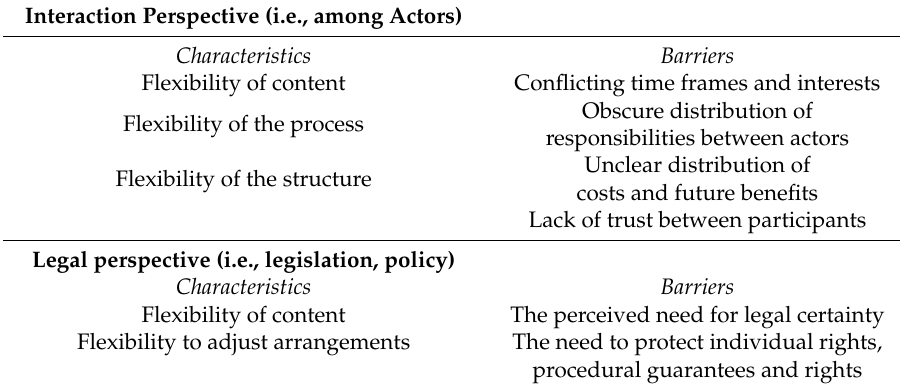
Table 2. Overview of characteristics of flexible arrangements and the barriers from an interaction and legal perspective; adapted from